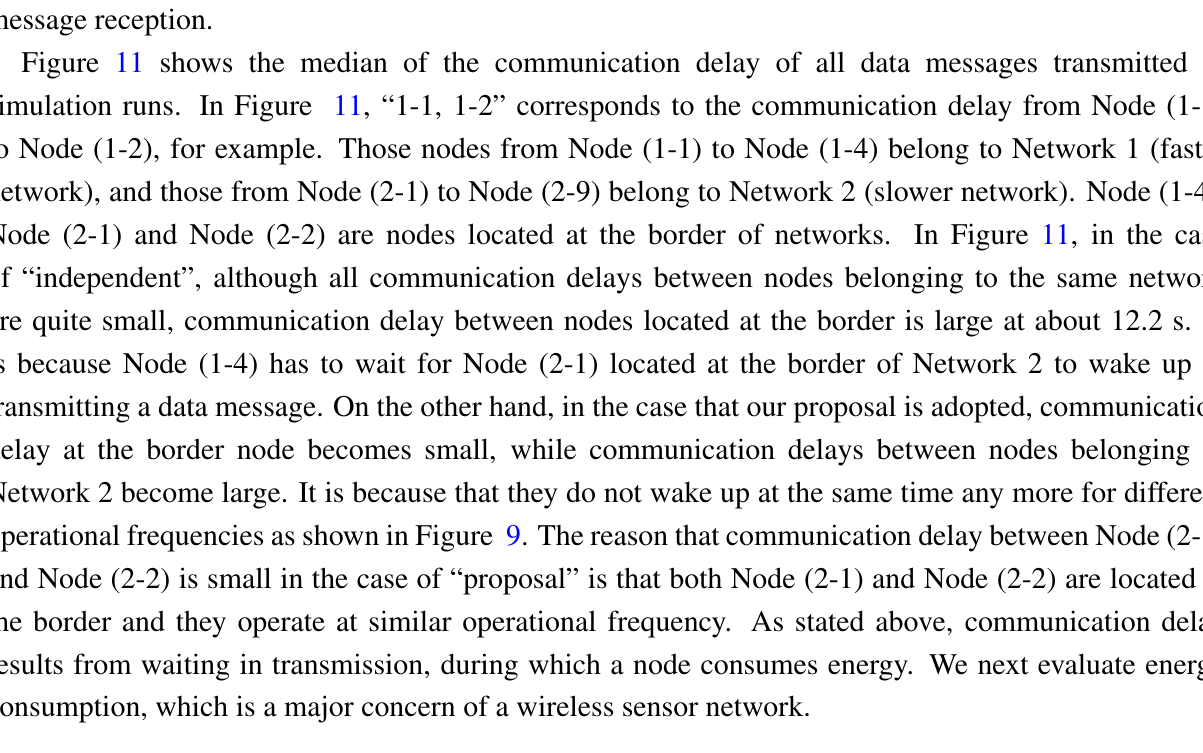
Figure 11. Communication delay of each